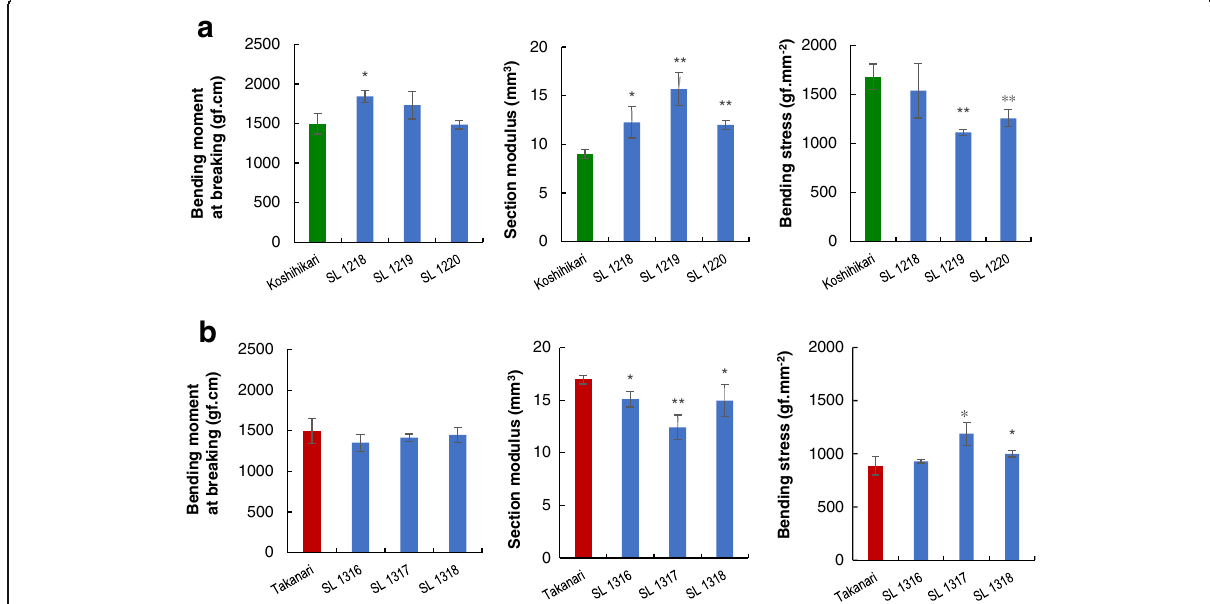
Fig. 5 Physical parameters associated with breaking-type lodging resistance in a K-CSSLs and b T-CSSLs of chromosome 5 in 2016. Data are expressed as the mean ± SD. *, and ** represent significant differences at 5 and 1% level, respectively